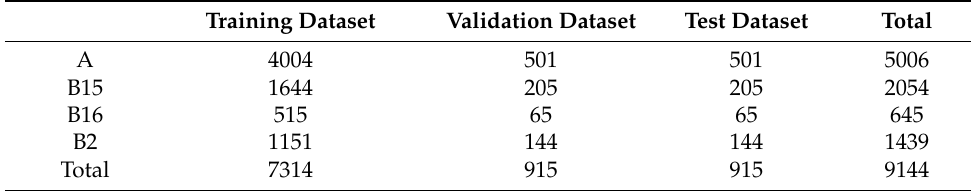
Table 1. The quantity of images used for training, validation, and test.